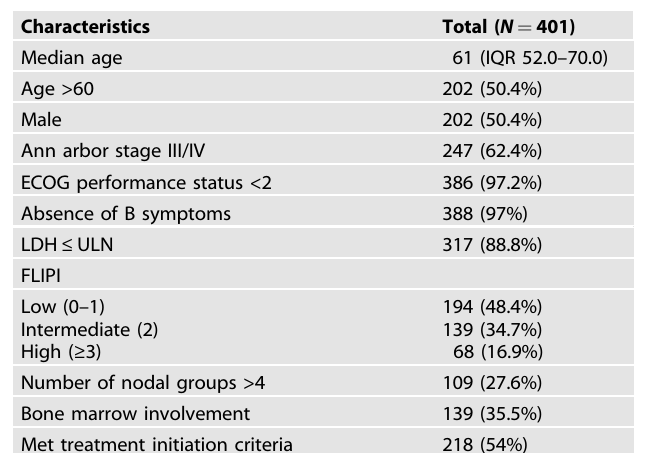
Table 1. Baseline characteristics of the follicular lymphoma patient cohort initiated on W/W strategy.